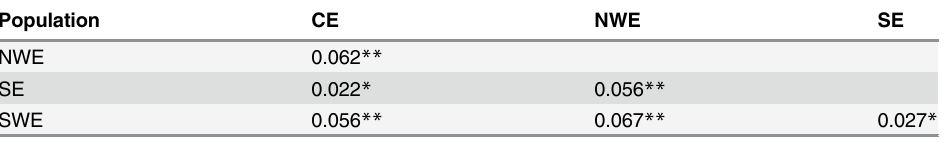
Table 6. Pairwise genetic distance based on F ST matrix, a measure of divergence among the Colleto- trichum species populations.